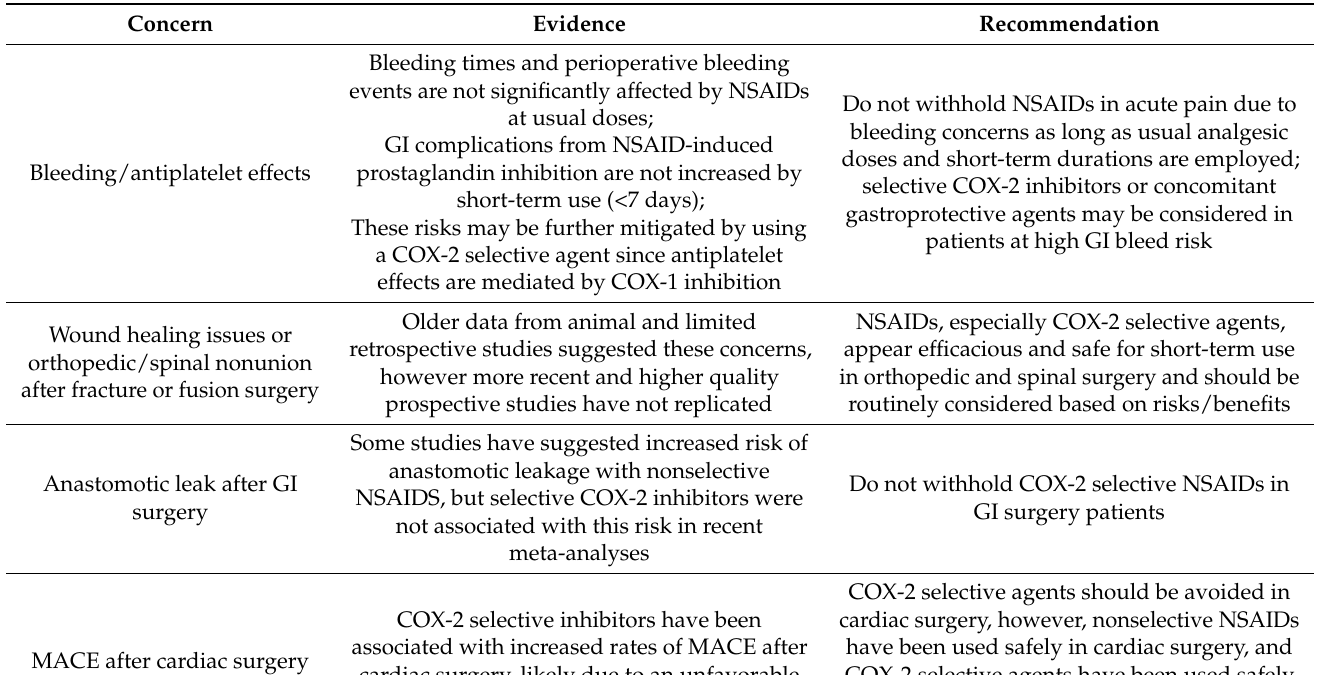
Table 1. Concerns and evidence relating to NSAIDs for acute pain management in the inpatient